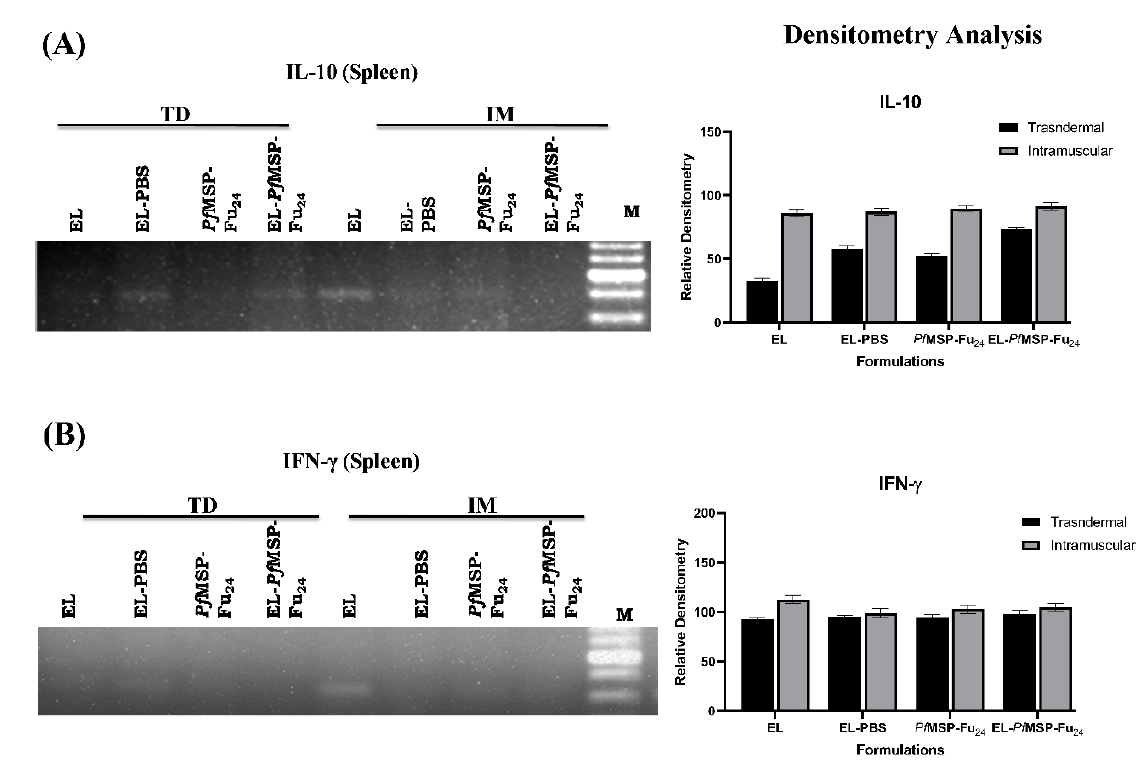
Figure 4. The transcript expression analysis of ( A ) IL-10 and ( B ) IFN- γ by RT-PCR in the spleen of BALB/c mice vaccinated with plain ( Pf MSP-Fu 24 ) and Pf MSP-Fu 24 -laden elastic liposomes (EL-PfMSP-Fu 24 ).